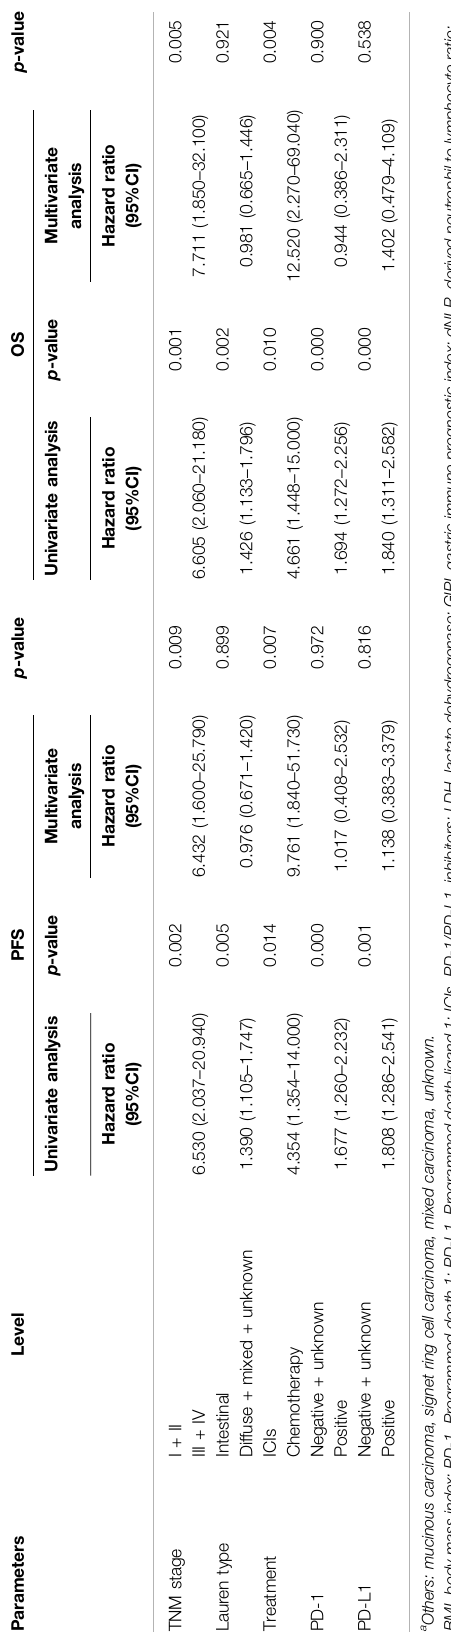
Table 1 . Blood Parameters The median of the white blood cell (WBC), neutrophil (NEU), lymphocyte (LYM), monocyte (MONO), eosinophils (EOS), basophil (BASO), red blood cell (RBC), and platelet (PLT) counts were 6.44 × 10 9 /L, 3.82 × 10 9 /L, 1.70 × 10 9 /L, 0.48 × D - P